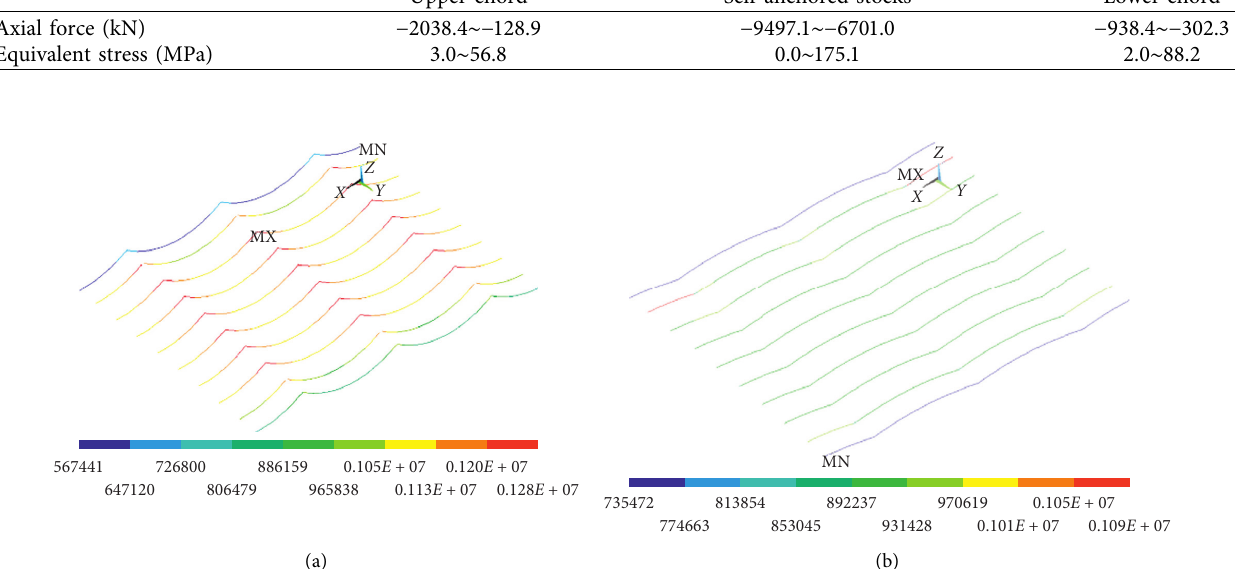
Figure 9: The cable forces distribution of secondary load-bearing structure, (a) the cable forces distribution of load-bearing cables (C1); (b) the cable forces distribution of stable cables